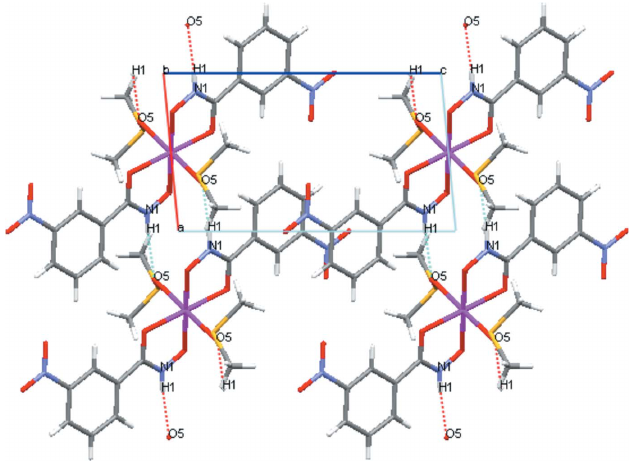
Figure 3 Hydrogen bonding in [Zn(NBZH) 2 (DMSO) 2 ] along the [100] direction.